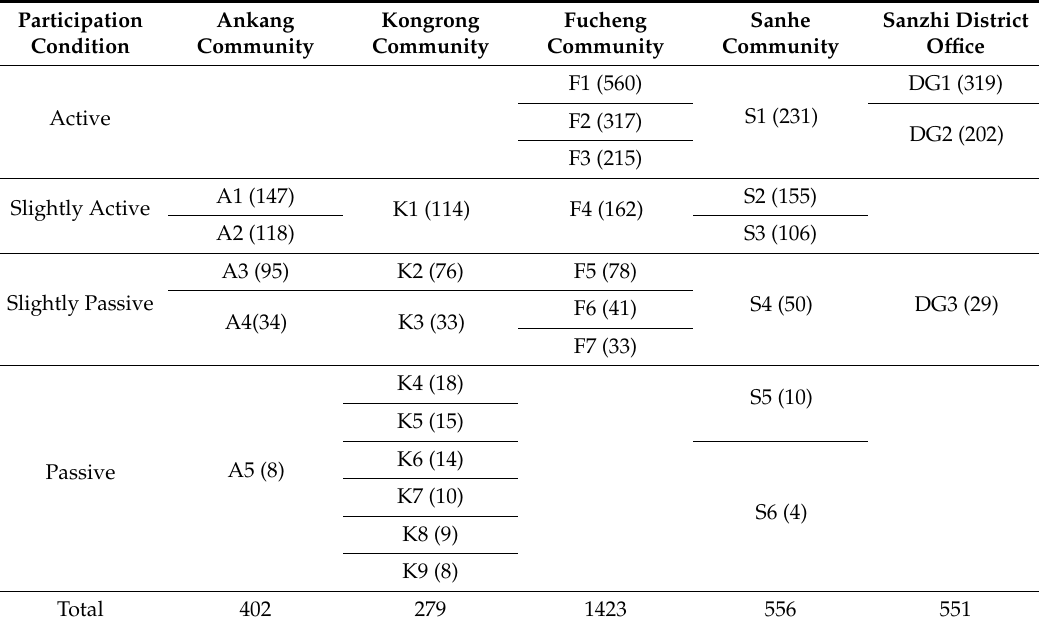
Table 4. The condition of discussion condition by actors from each community.